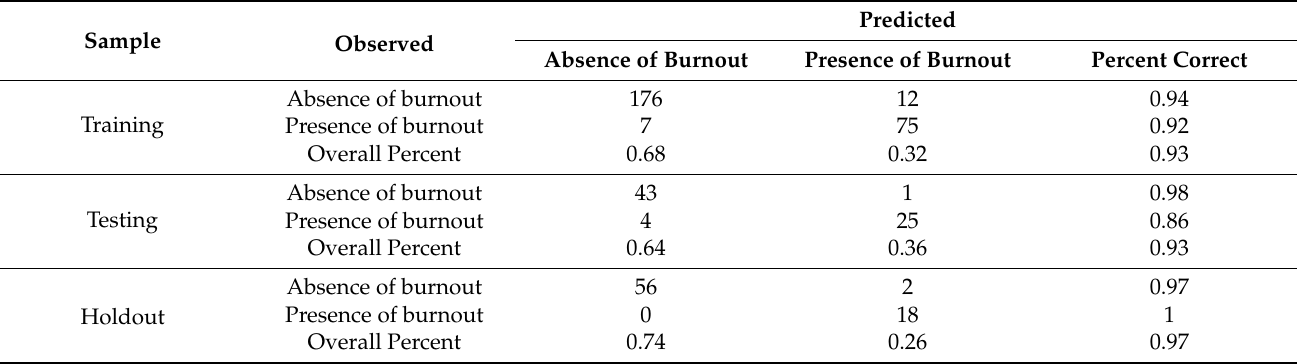
Table 4. Predictive capability of the artificial neural